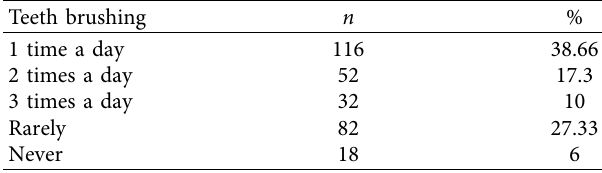
Table 6: Frequency of daily teeth brushing. Teeth